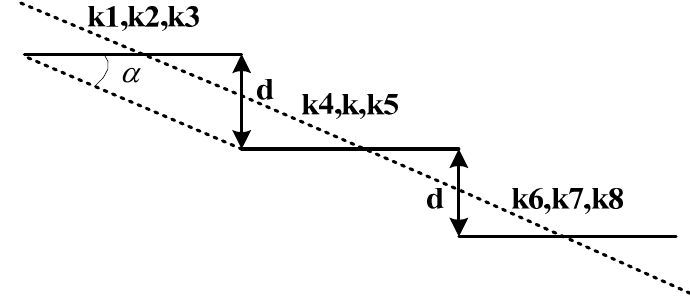
Figure 4. Cross section view of the central DEM cell and its adjacent cells.